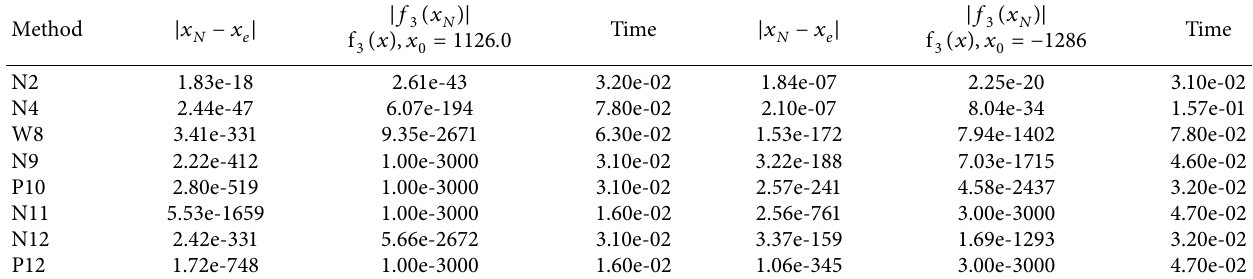
Table 3: Comparison of several methods with the same number of iterations ( N � 3 ) for the Problem 7. Method